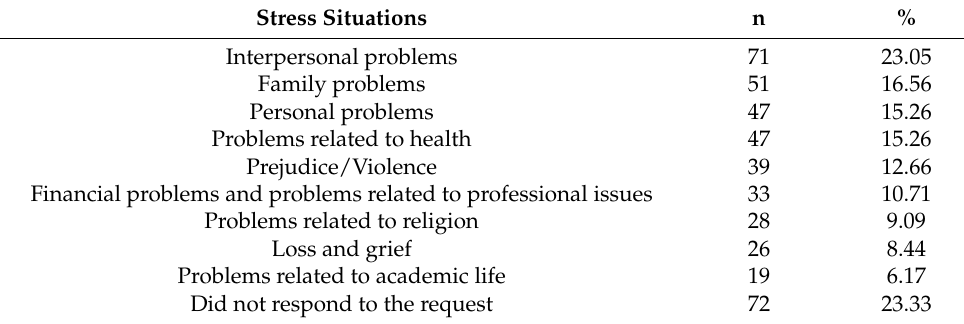
Table 2. Categories of stress